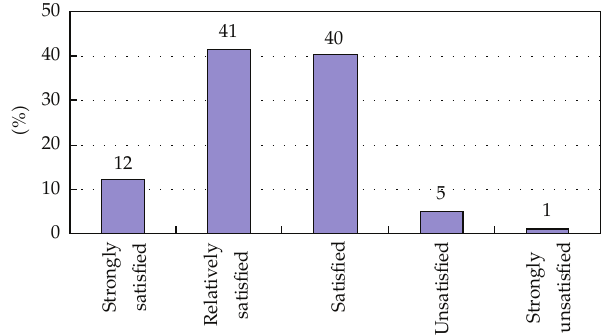
Figure 6: Satisfaction for transferring at park and ride